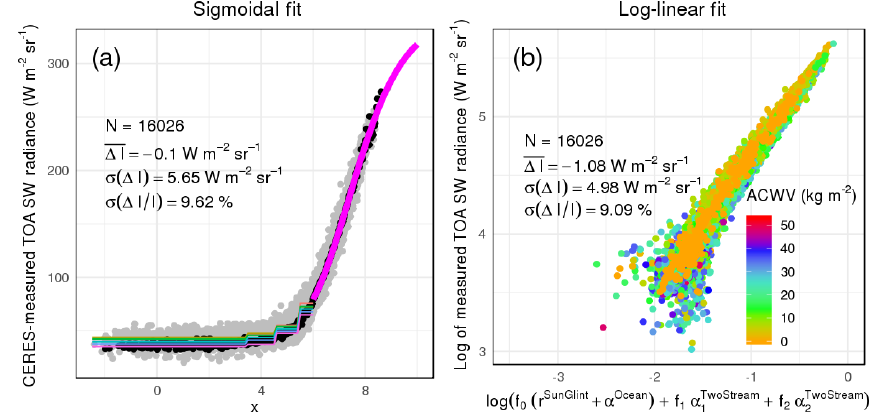
Figure 1. For an example angular bin ( θ 0 ∈ [ 20 ◦ , 22 ◦ ] , θ v ∈ [ 6 ◦ , 8 ◦ ] , ϕ ∈ [ 12 ◦ , 14 ◦ ] ), we show how a state-of-the-art sigmoidal fit (a) and proposed log-linear model (b) capture fluctuations of CERES-measured TOA SW radiances. As this angular bin is within the sun-glint region, panel (a) shows the lookup-table approach for x < 6 (as defined in Sect. 3.1; note that f 1 and f 2 are taken between 0 and 100 in panel a and between 0 and 1 in panel b ). Colors in (b) mark the amount of above-cloud water vapor. Statistics in both panels summarize each approach’s number of samples, bias, and SD of radiance residuals as well as relative